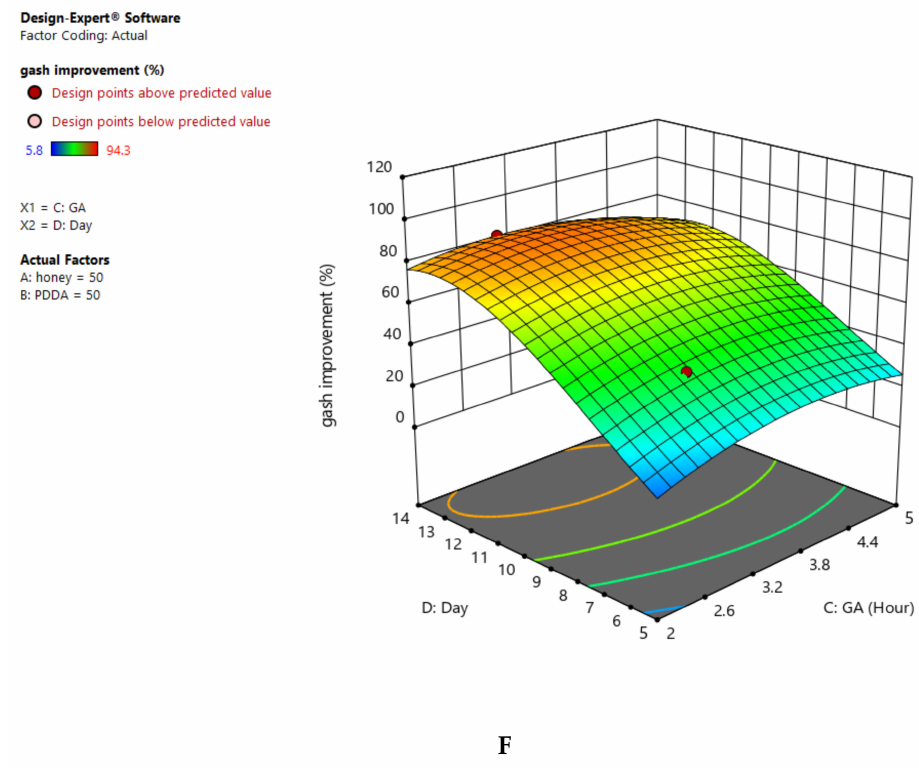
Figure 8. ( A ) A 3D diagram for the effects of honey (%) and PDDA (%) on wound-healing, ( B ) 3D diagram for the effects of honey (%) and crosslinking duration (h) on wound-healing, ( C ) 3D diagram for the effects of honey (%) and static time on wound-healing, ( D ) 3D diagram for the effects of crosslinking duration (h) and PDDA (%) on wound-healing, ( E ) 3D diagram of the effects of PDDA (%) and static time on wound-healing, and ( F ) 3D diagram of the effects of crosslinking duration (h) and on